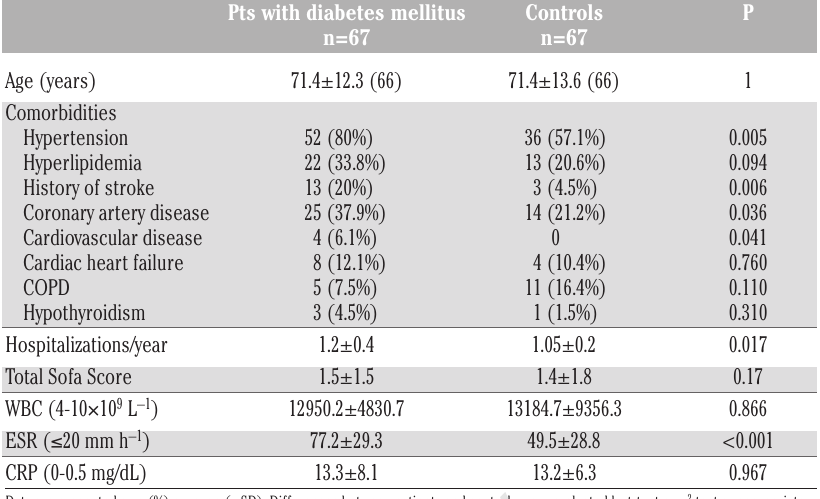
Table 2. Type of infections on admission.